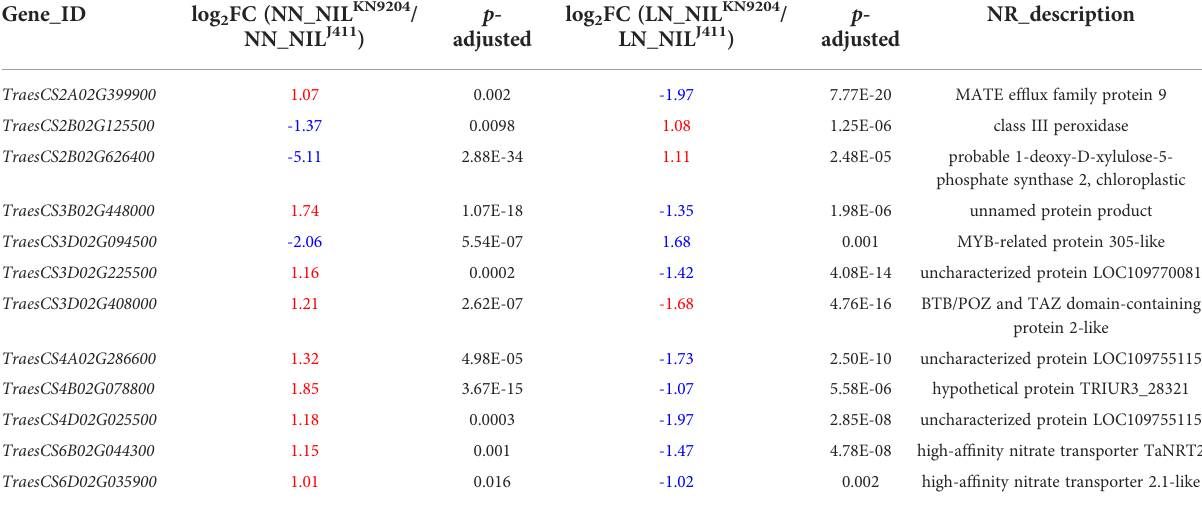
TABLE 1 DEGs with opposite expression patterns between the pairwise NILs under NN and LN conditions.